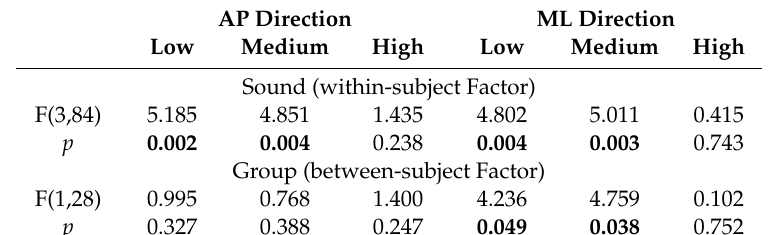
Table 1. The results of repeated measure ANOVA for the low-frequency, medium-frequency, and high-frequency band in the anterior–posterior and medial–lateral directions.